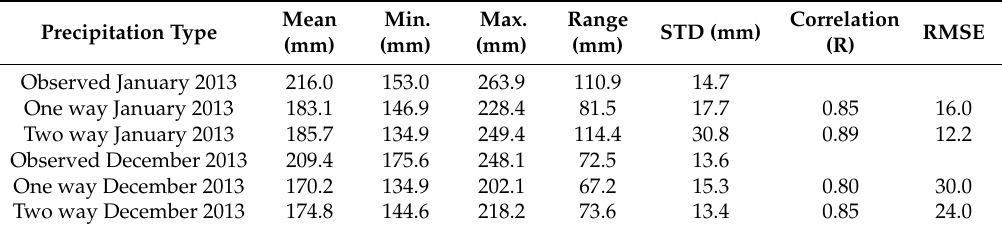
Table 1. Total storm precipitation, mean, min., max., range, correlation and the RMSE for the observed precipitation, one way and two way simulated